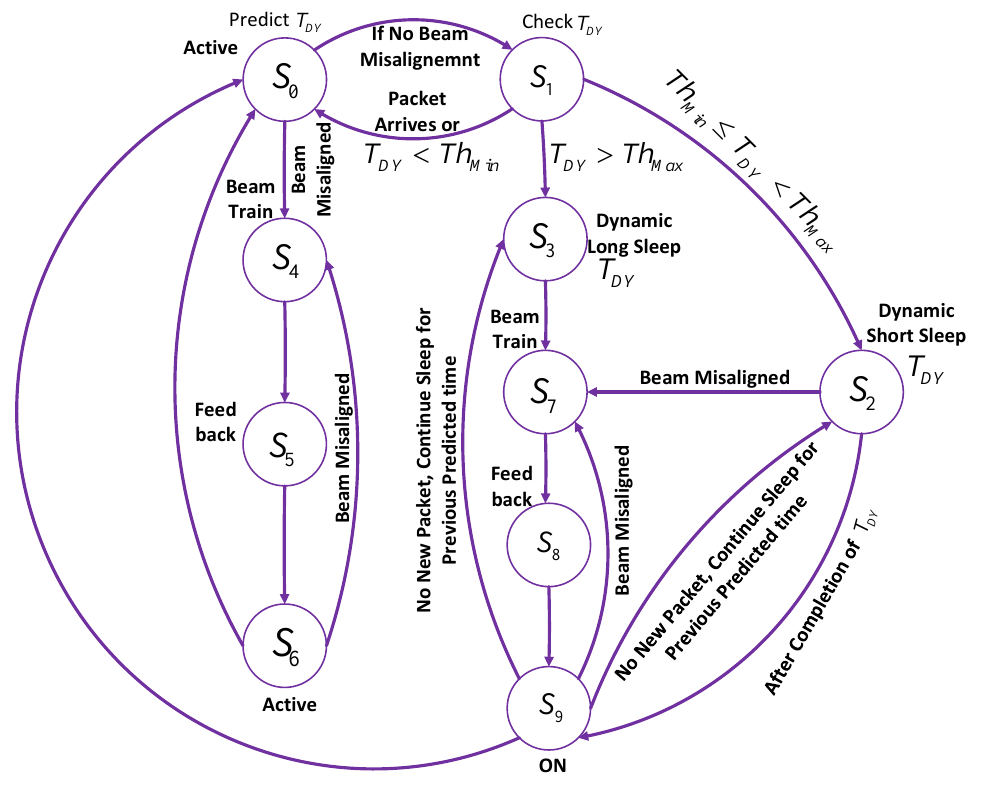
Figure 5. State diagram for